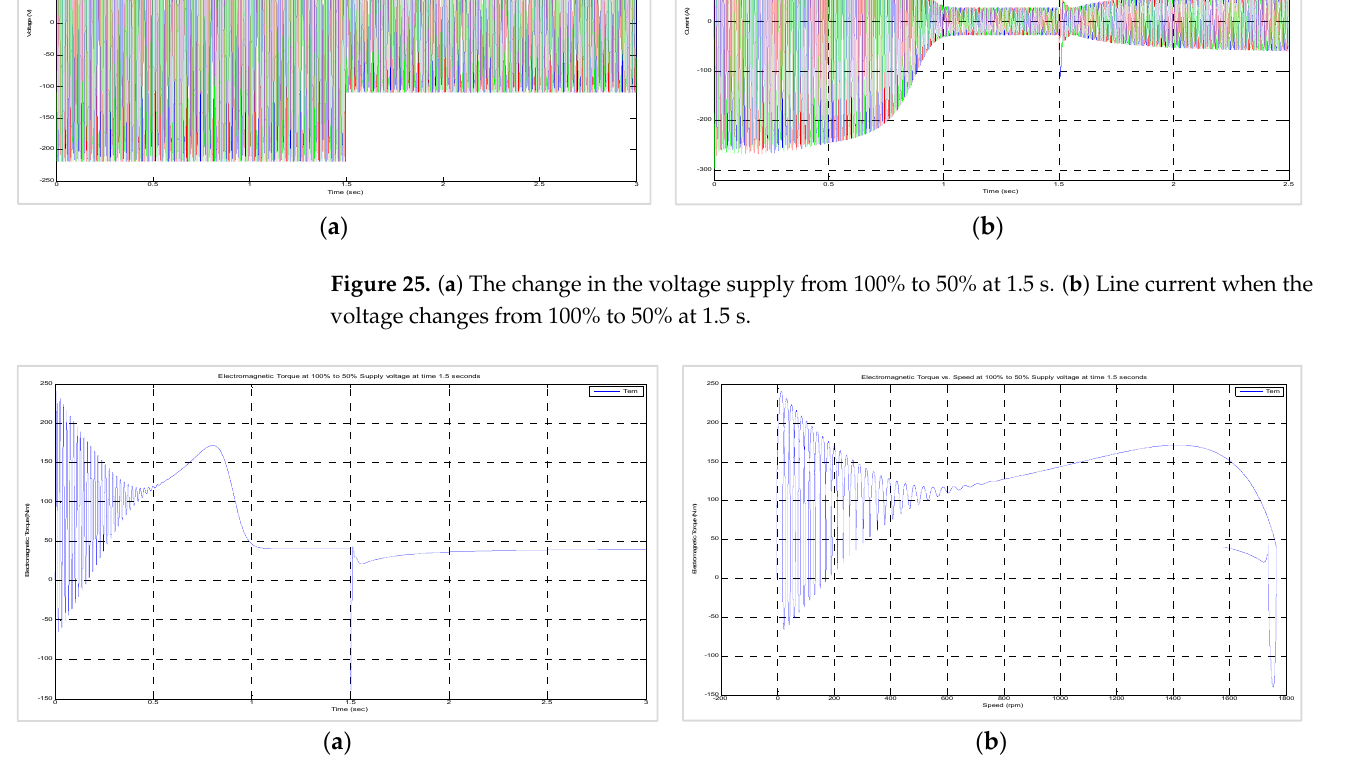
Figure 27. The speed when the supply voltage changes from 100% to 50% at 1.5 s. 9. Conclusions The performance of the stator and rotor variables was effectively studied by utilising dynamic and static Simulink designs for the modelling of an induction machine. In con- trast to several existing induction machine design applications, the operator has access to all internal parameters in this design in order to gain knowledge about the machine’s op- erations. By utilising such designs, any machine control method can be modelled in the Matlab/Simulink software without estimation techniques. For every module, individual variable calculations were performed. Each designer’s function was modelled, and critical variables were observed. In this work, a dq0-direct axis algorithm was presented in order to implement both static and dynamic modelling of a three-phase induction machine due to possible faults and high-performance requirements for induction machines. The proposed algorithm was compared with several conventional methods. It was observed that under stable condi- tions of the machinery, the proposed algorithm could remove any developing faults. This conserves time and minimises the labour required of an operator, which makes the pro- posed algorithm more efficient. Furthermore, the machine demonstrated a steady-state performance with respect to the current, active power, efficiency, reactive power, power factor, and speed when the torque loads ranged from 0% to 125% of the nominal torque. The transient behaviour of the machine was shown through the current, electromagnetic